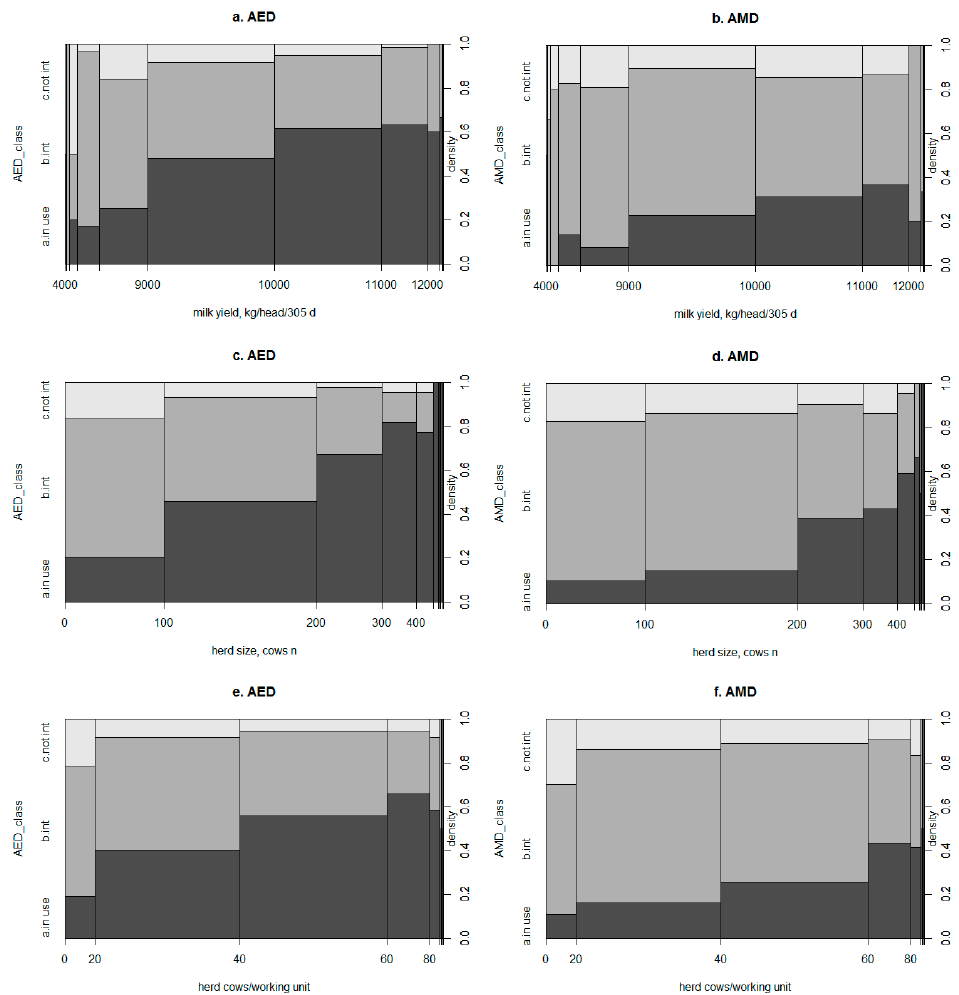
Figure 1. Spinograms for the distribution of farms with at least one sensor for ( a , c , e ) automated estrus detection (AED) or for ( b , d , f ) automated mastitis detection (AMD) with the ( a , b ) herd average 305- day MY (kg/head), ( c , d ) herd size (lactating plus dry cows n) and ( e , f ) cows per working unit ratio (n) as independent variables. The three different areas represent the proportions of interviewed farmers that used (dark-gray), were interested (medium-gray), or were not interested in using (light-gray) at least one form of the technology. The widths of the bars correspond to the relative frequencies of x, and the heights correspond to the conditional relative frequencies of y in every x interval.